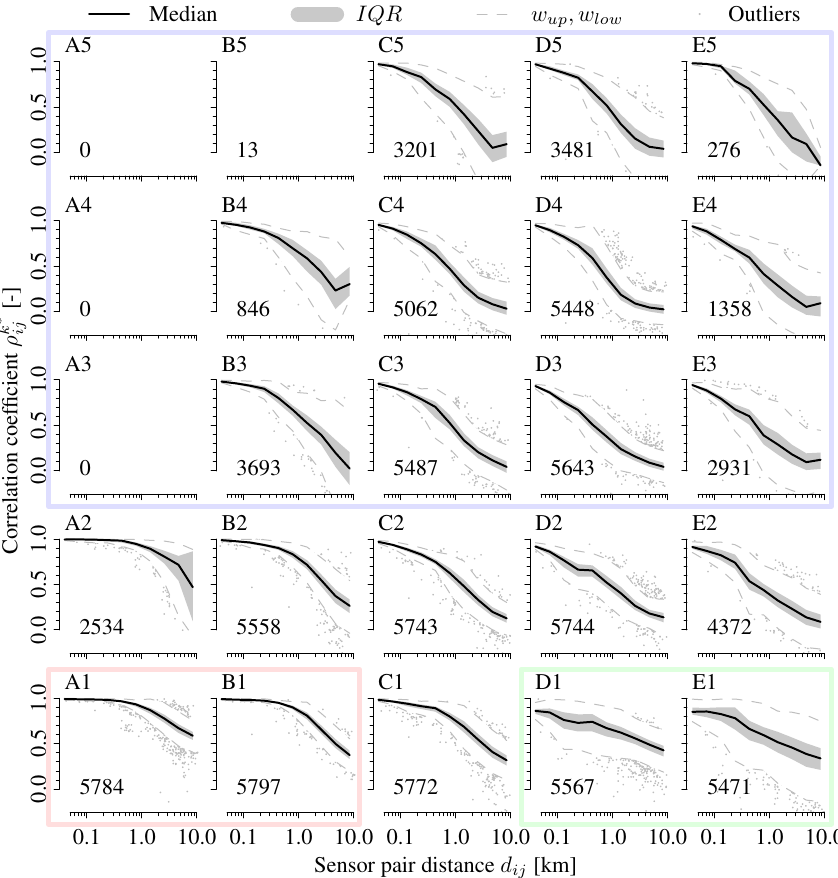
∗ k ∗ as functions of sensor pair distance d ij for each of the grid Figure 4. Spatial two-point correlation coefficients ρ k ij of clear-sky index boxes from Fig. 3, based on data from both field campaigns. The summary statistics (cf. Table 1) are based on 10 logarithmically scaled bins of d ij , and include only those sensor pairs whose members simultaneously correspond to the same grid box for at least 60min. The total number of pairs used to derive the statistics is given in each panel. Grid boxes to be subsequently grouped as similar sky types are indicated by colored